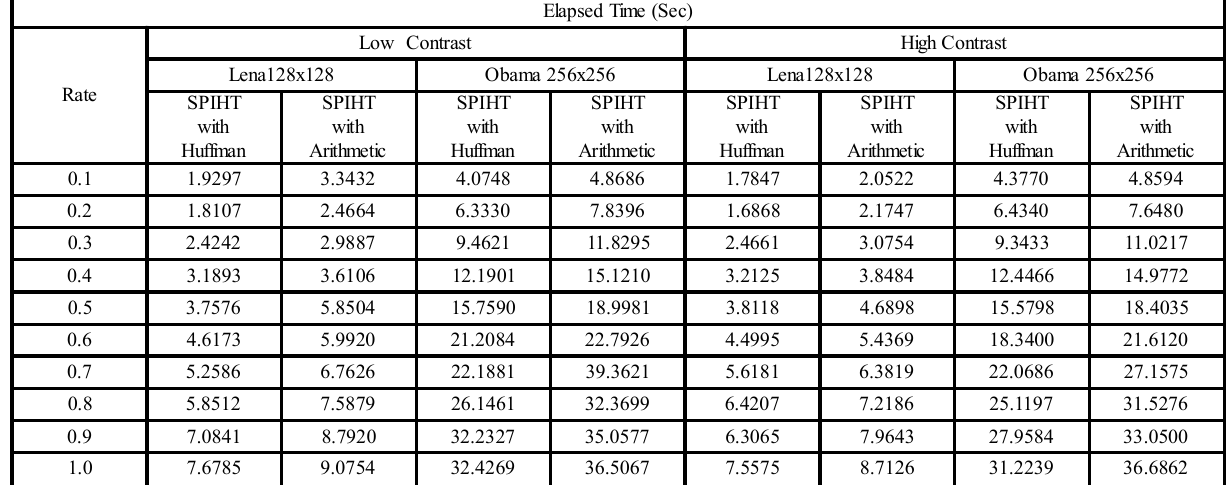
TABLE 9. ELAPSED TIME FOR BOTH ALGORITHMS FOR LOW AND HIGH CONTRAST IMAGES